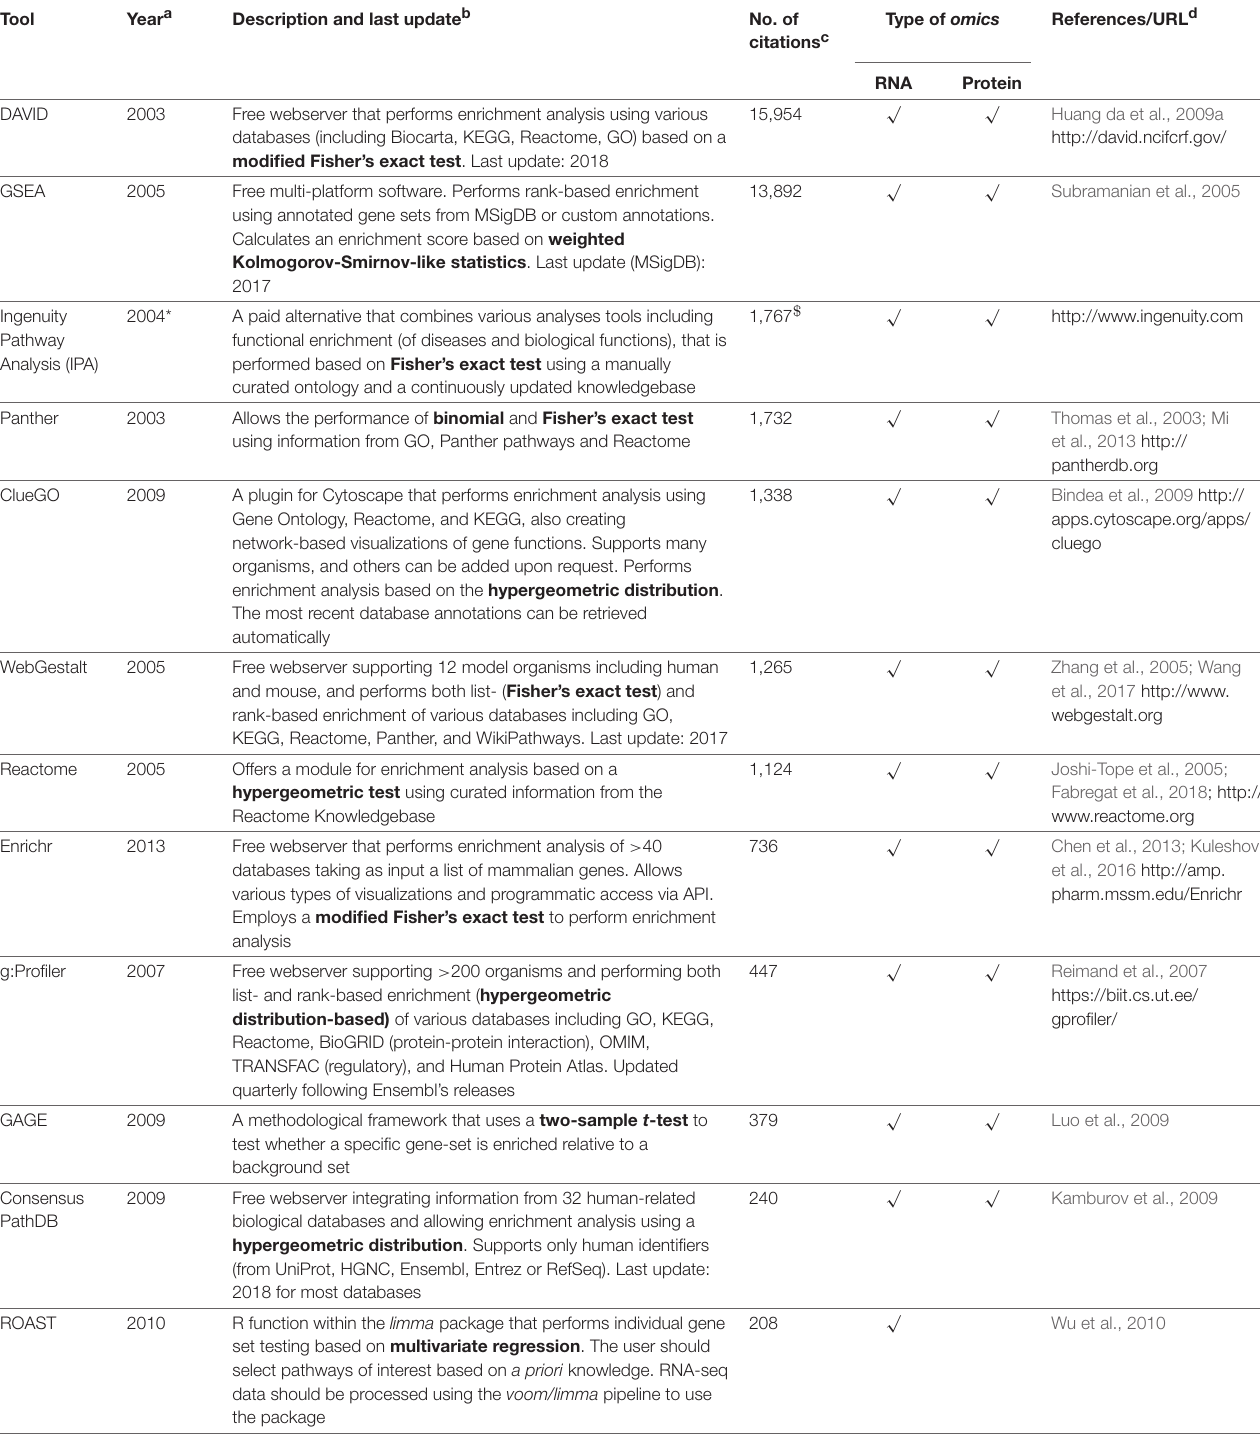
TABLE 1 | Computational tools for performing functional enrichment analysis using omics datasets.